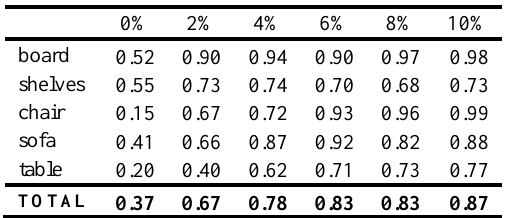
Table 3. Evaluation of accuracy by class according to the percentage of point cloud images in the training set with point cloud images in the validation set.